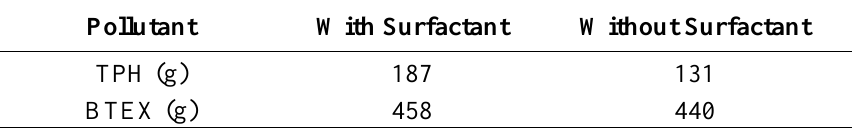
Table 2. TPH and BTEX removed during pilot-scale operation at a petroleum-polluted military site. Pollutant With